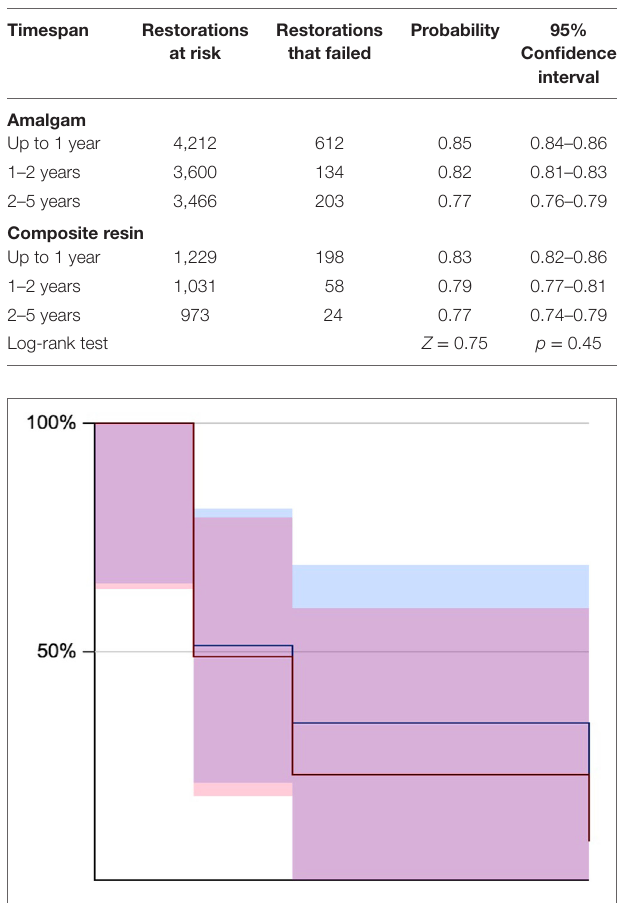
FigUre 2 | Kaplan–Meier survival estimates for 1, 2, and 5 years (blue for amalgam restorations and in pink composite resin restorations). Corresponding data can be found in Table 2